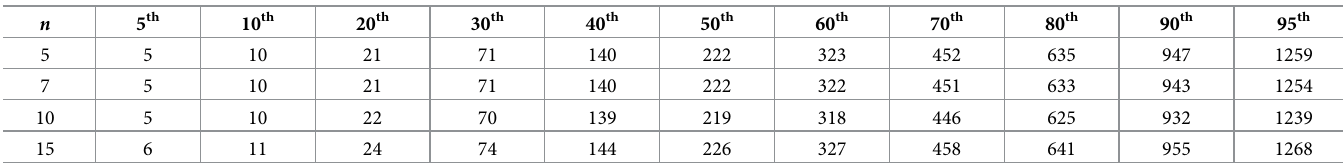
Table 5. In-control percentiles of the run length distribution for the EARL -based side sensitive synthetic- γ chart for γ 0 = 0.05, n 2 {5,7,10,15} and ( τ min , τ max ) = (1,2]. n 5 th 10 th